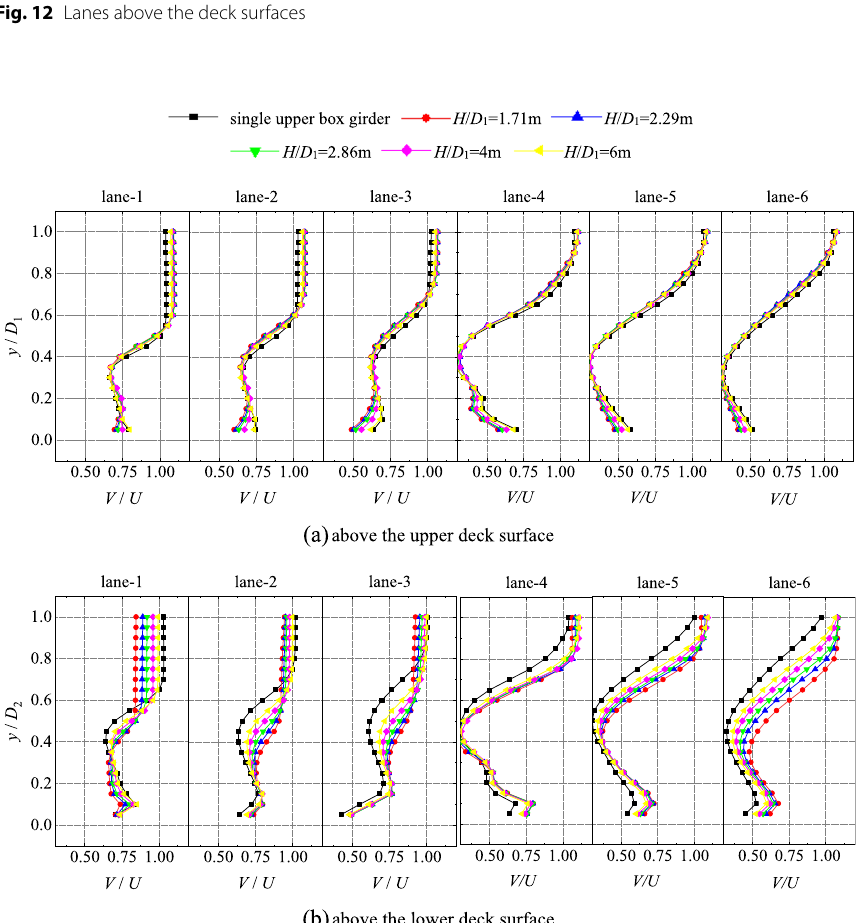
Fig. 13 Wind profiles of the normalized mean streamwise